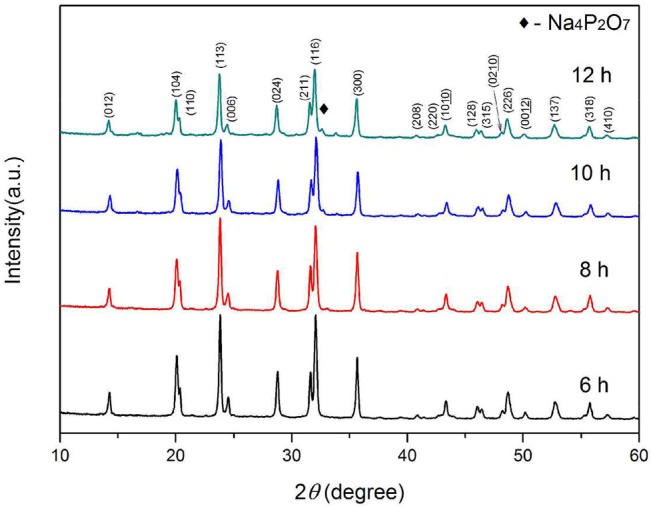
XRD patterns of Na3V2(PO4)3/C synthesized at different calcining times.